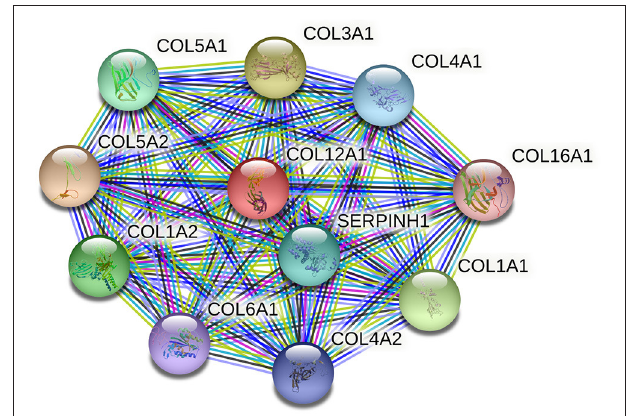
FIGURE 1 | The protein–protein interaction (PPI) network of COL12A1 and its closest functional neighbors. The PPI network is generated using STRING (available at http://string-db/org). Network nodes represent proteins and the edges indicate both functional and physical protein associations.